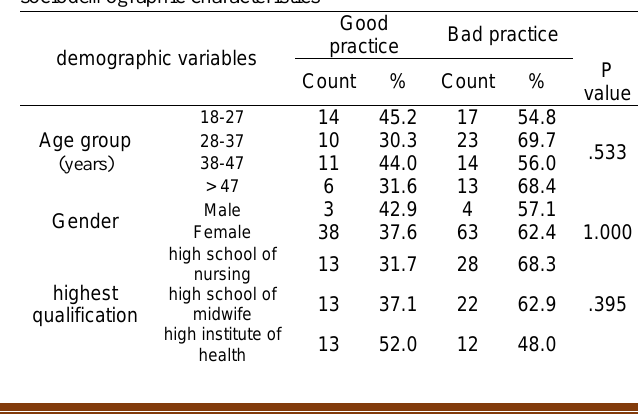
the association of attitude scores to some sociodemographic